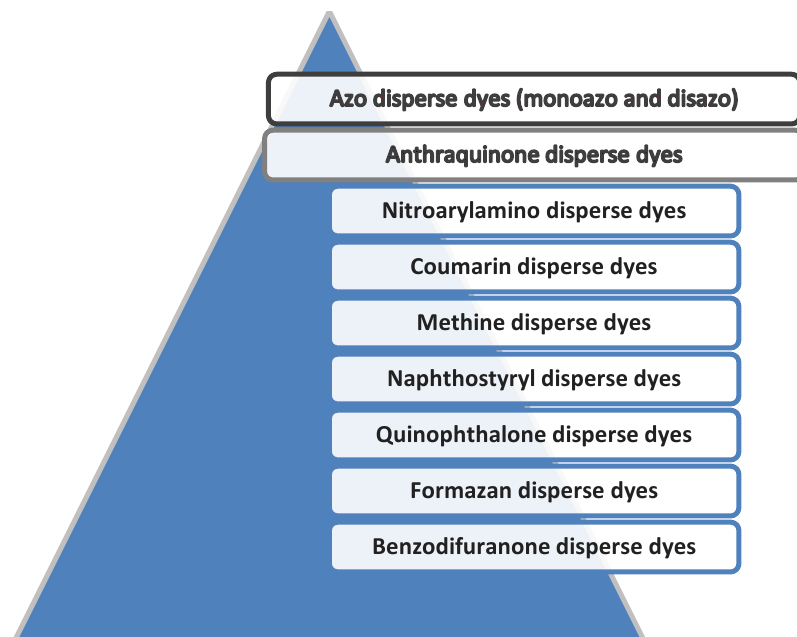
Figure 1. Classification of disperse dyes by chromogen.